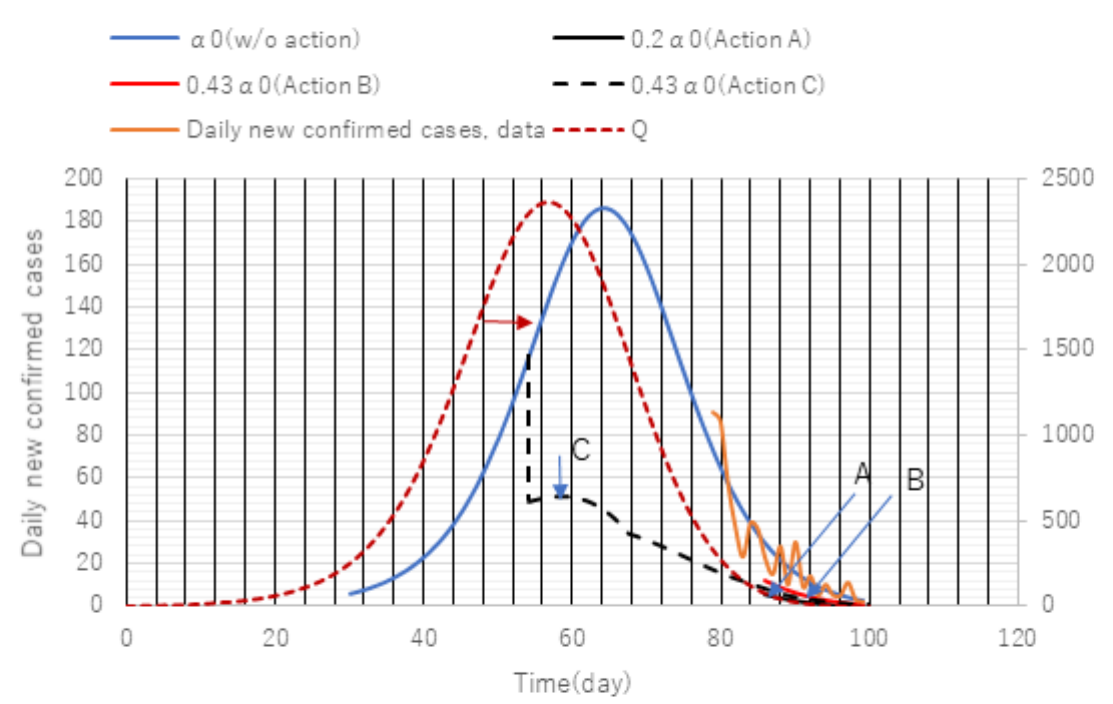
Figure 9. A posteriori assessment of the impact of restrained contact to reduce transmission rate, α . Stepwise change in the value of transmission rate α from α 0 to 0.2 α 0 (action A) or to 0.43 α 0 (action B) was applied at day 86 when the effect of the action should appear on daily new confirmed cases. Solid lines represent daily new confirmed cases (left axis) while the red broken line (infectious cases at large) to the right. It was found that “real”